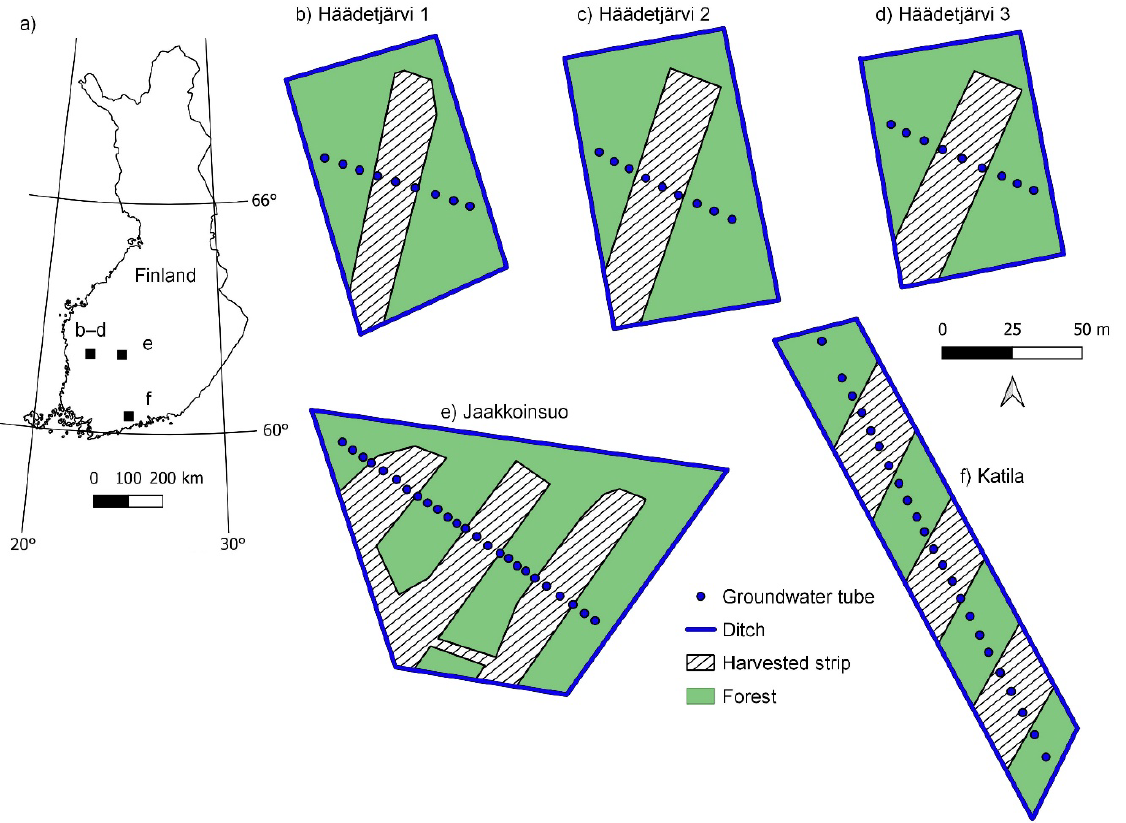
Figure 1. Locations of the study sites within Finland ( a ) and detailed maps of the strip cuttings ( b – f ) with groundwater tubes on the drained nutrient-poor forested peatlands. The stands are dominated by Scots pine.